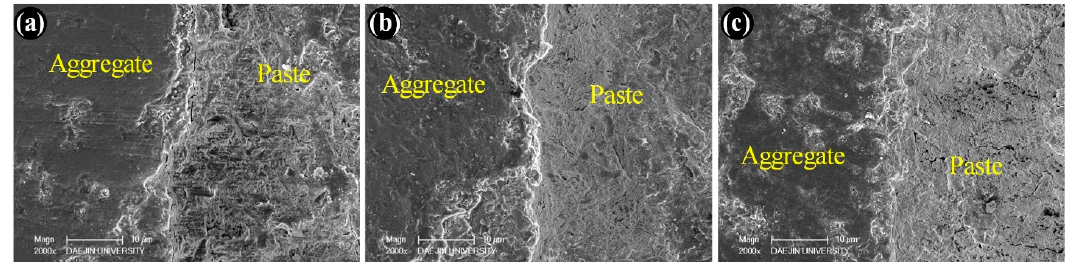
Figure 8. SEM micrographs of concrete containing silica fume and ( a ) basalt, ( b ) quartzite, and ( c ) granite coarse aggregates.